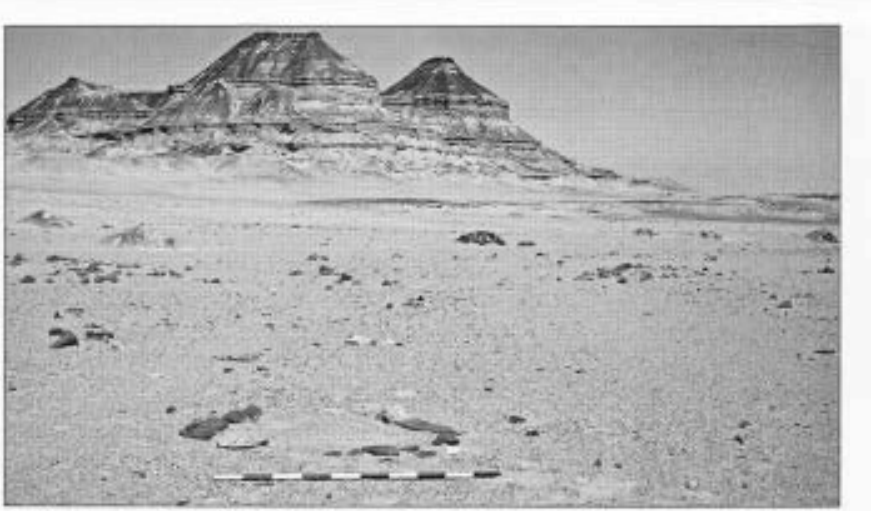
Figure 1 0 Hearth in the encampment (foreground) -Widan el-Faras basalt